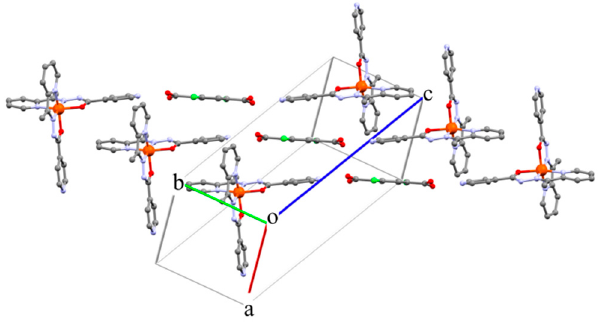
Figure 2. The π - π interaction between [Fe(L) 2 ] and H 2 Cl 2 TPA in 1-Cl .